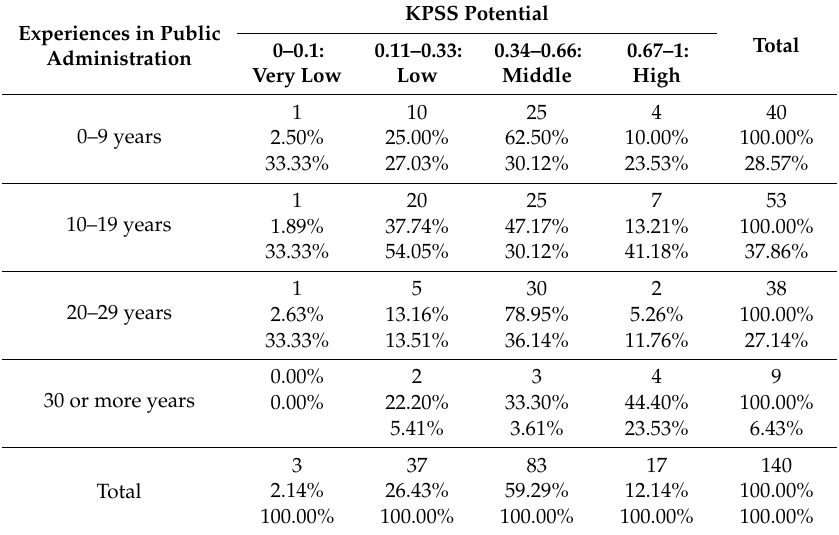
Table 11. Experiences in public administration × Community planning Potential (count, row %, column %, total %).